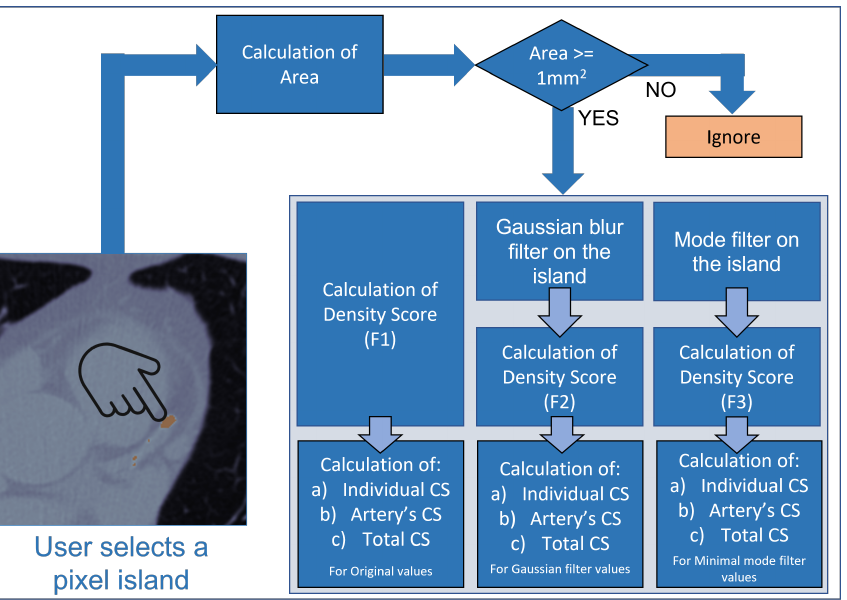
Figure 4. CS calculation